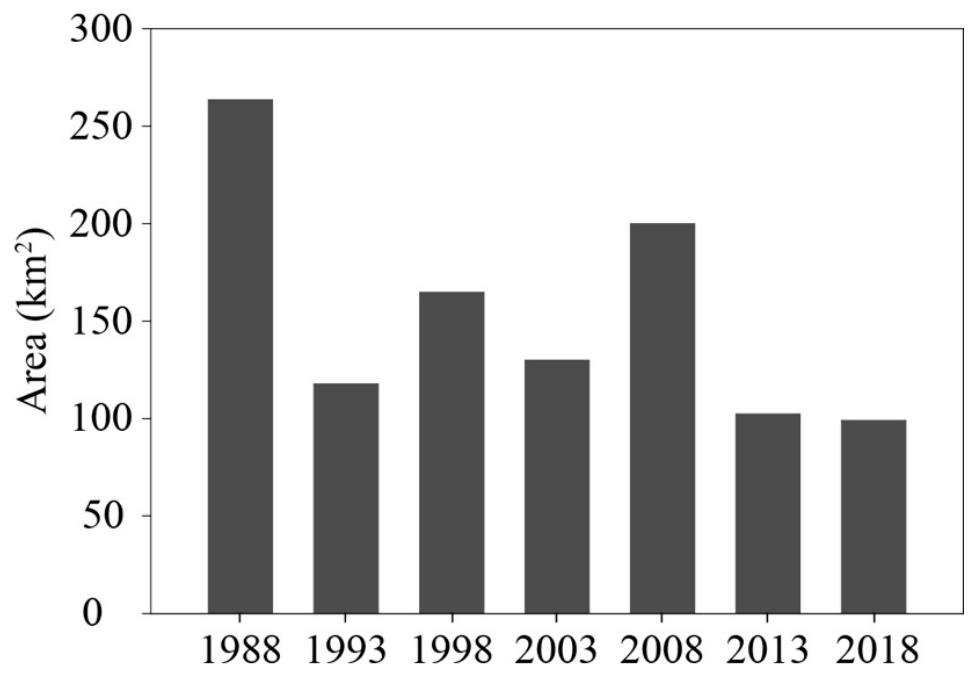
Figure 3. Total S. salsa saltmarsh area at different stages between 1988 and 2018 along the NYSC.